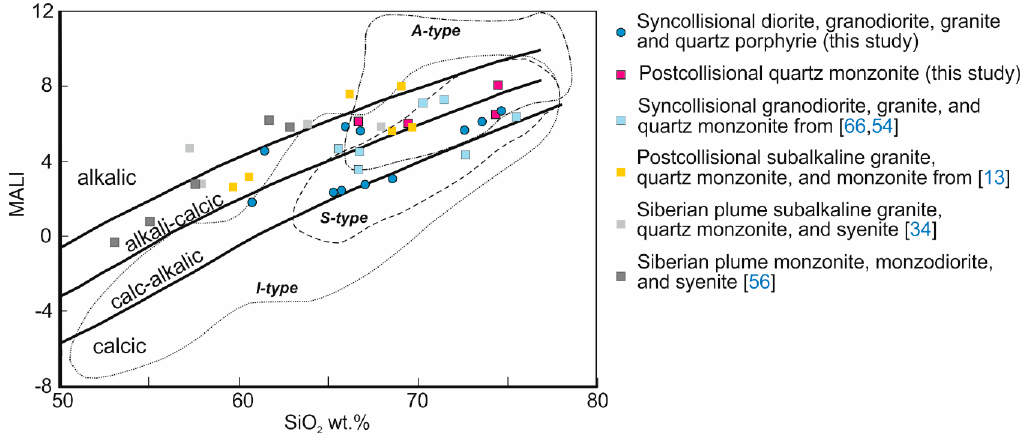
Figure 10. MALI (Na 2 O + K 2 O-CaO) vs. wt.% SiO 2 diagram after [98] for the studied felsic rocks. Dashed lines show fields of A-type, I-type and S-type granites from the Lachlan Fold Belt [98].